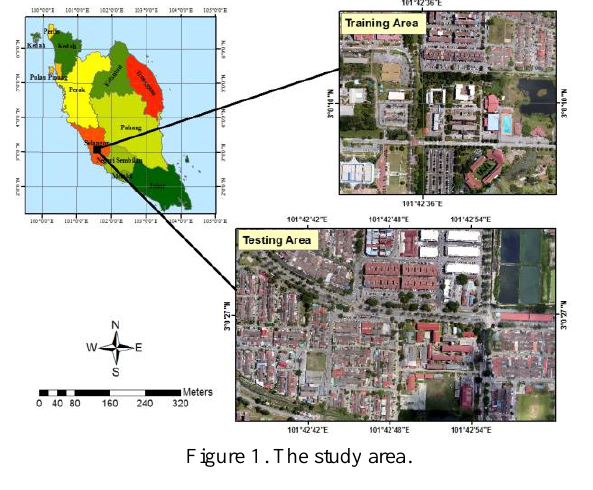
Figure 1. The study area.